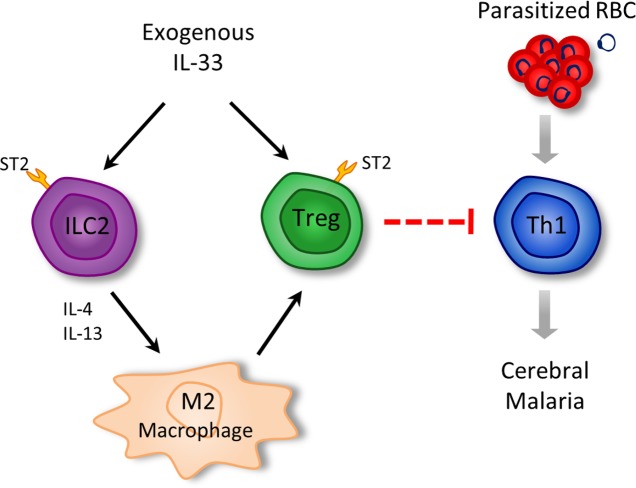
Schematic representation of the pathways by which IL-33 attenuates ECM.Arrows represent activation/promotion; dotted blunted arrows = proposed mechanism of suppression.